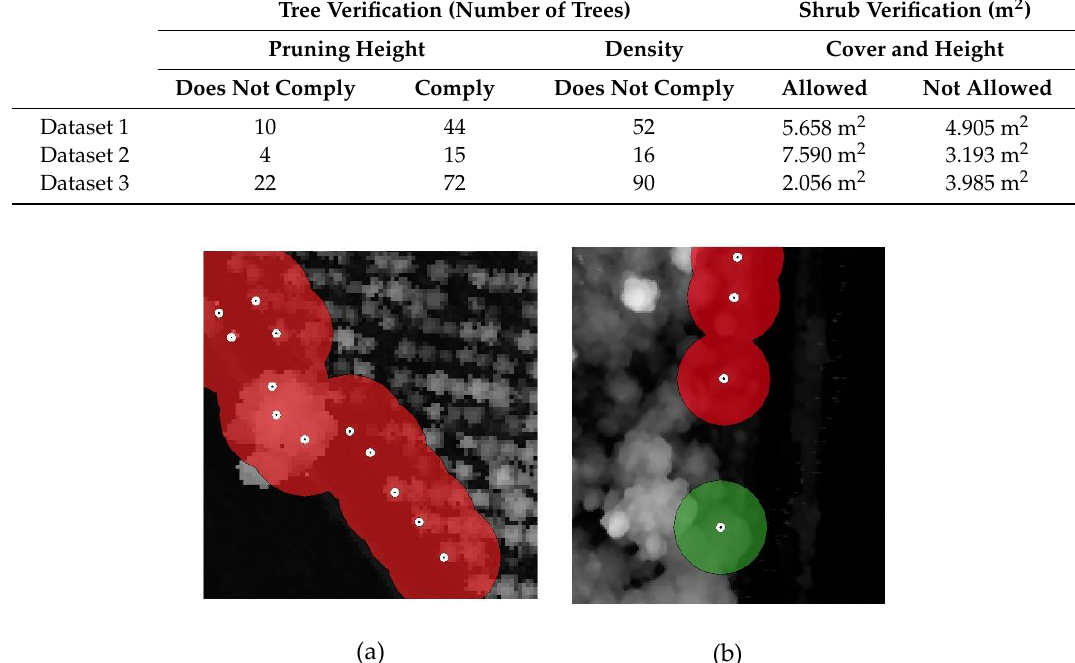
Figure 13. Results for tree density verification for Datasets 3 ( a ) and 2 ( b ). Tree points in biomass